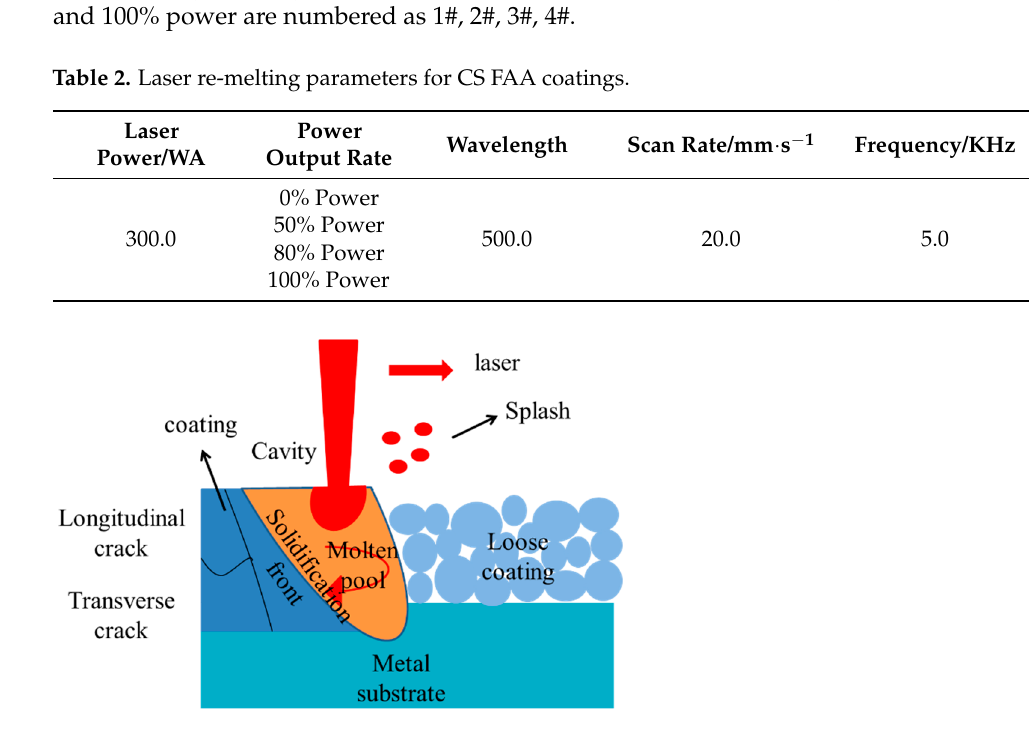
Figure 2. Schematic diagram of laser re-melting principle for coating densification.